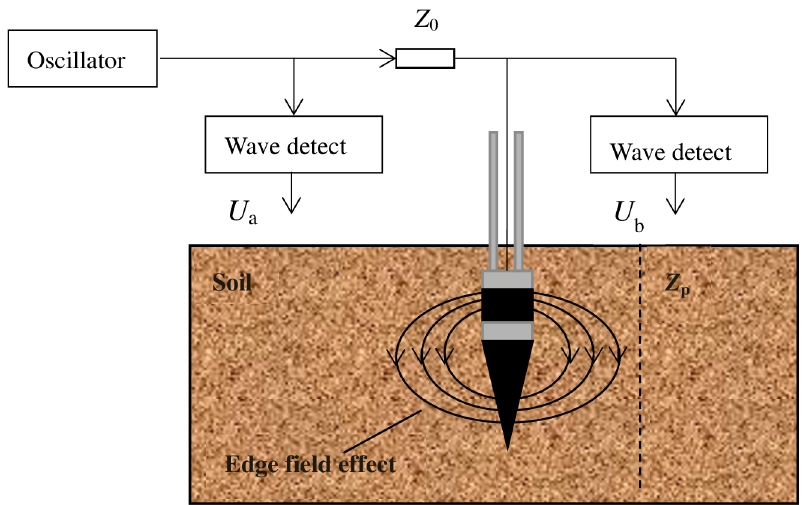
Fig 3. Schematic diagram of the soil water content